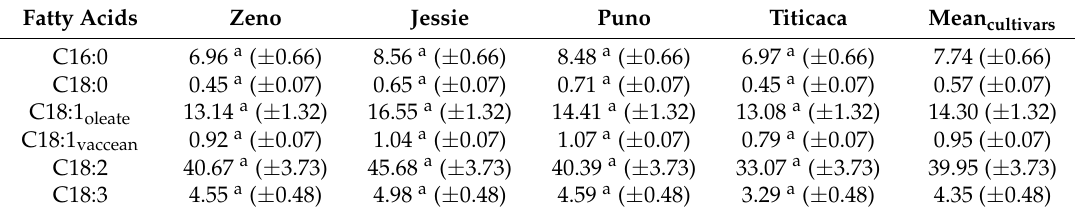
Figure 6. Two-year mean values of grain crude fat (%) for the four quinoa cultivars (Zeno, Jessie, Puno, Titicaca). Bars headed by the same letter are not significantly different at p < 0.05. Error bars indicate the standard error of the mean. Table 8. Two-year mean values of fatty acid composition (in g 100 g − 1 crude fat, ± SE 1 ) for the four quinoa cultivars (Zeno, Jessie, Puno, Titicaca). Means in one row followed by the same letter are not significantly different from each other ( p <